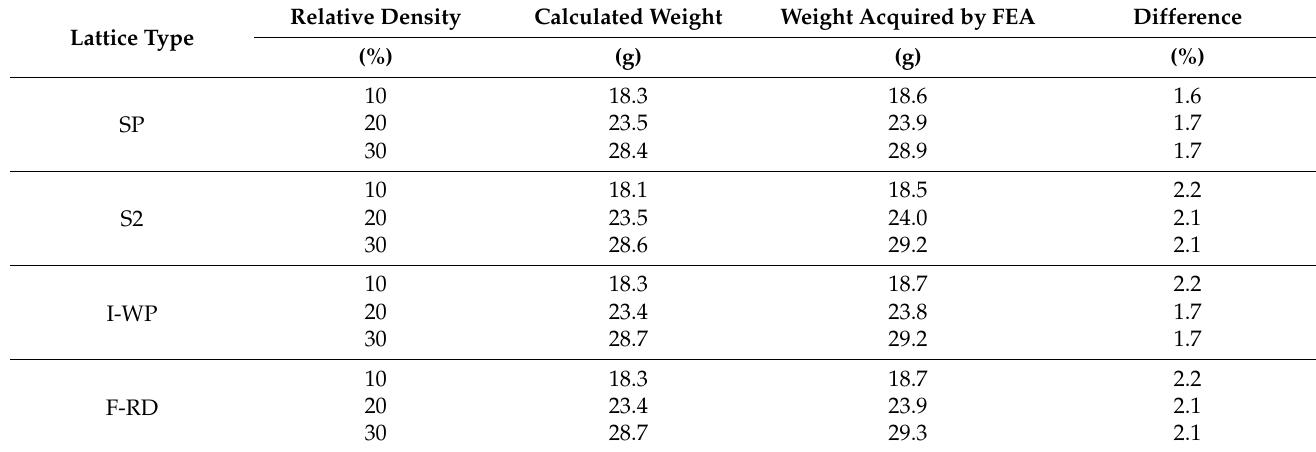
Table 5. Differences between the calculated weight and numerical prediction for each SPS.